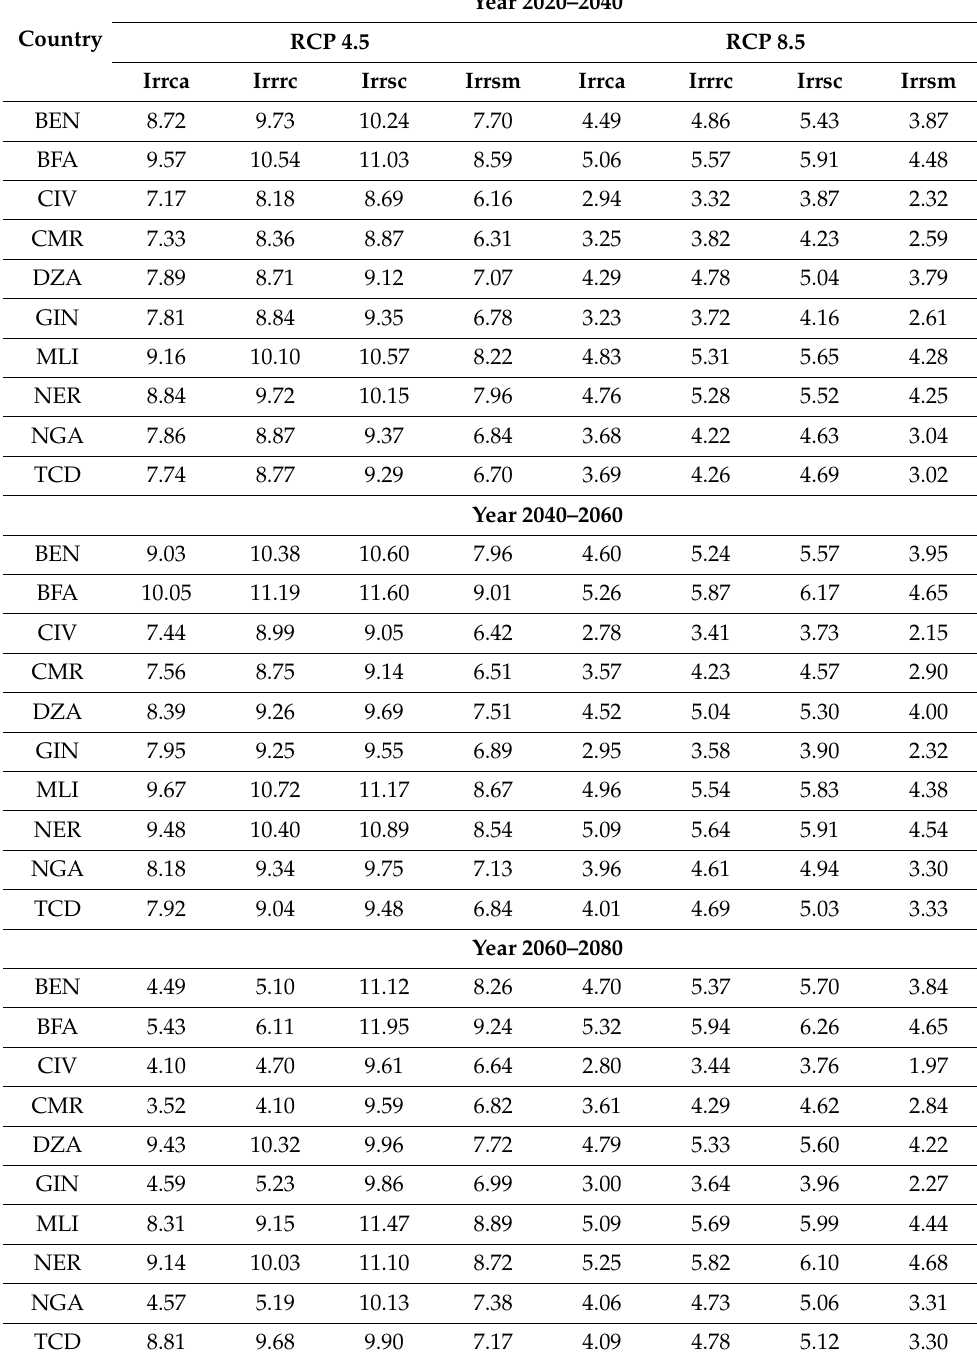
Table 1. Total irrigation water requirements (IRW) in mm/day under